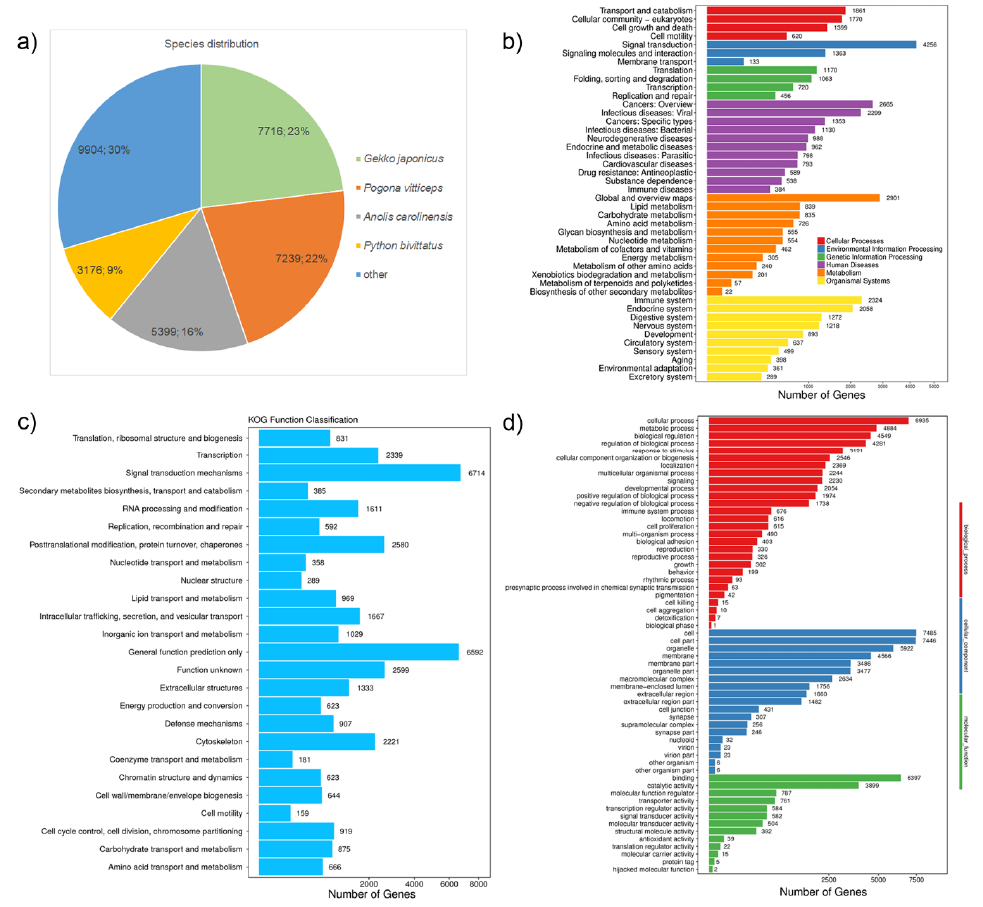
Figure 2. Annotation of the Asymblepharus ladacensis transcriptome. ( a ) Species distribution of the top BLASTx hit performed against NR database; ( b ) GO (Gene Onthology) assignments as predicted by Blast2GO; ( c ) functional distribution of KOG (EuKaryotic Orthologous Groups) annotation and ( d ) KEGG (Kyoto Encyclopedia of Genes and Genomes) classifications of assembled transcripts. In terms of the biological process ontology (GO database categories), the most com- mon categories were cellular processes (6935), metabolic processes (4884), and biological regulation (4549). The most frequent classifications for the cellular component ontology were cellular (7485), cell compartments (7446), and organelles (5922). Regarding the mo- lecular function, major categories involved binding (6397), catalytic activity (3899), and molecular function regulator (787) (Figure 2). The KOG functional classification revealed genes of signal transduction mechanisms (6714), general function (6592), unknown func- tion (2599), posttranslational modification (2580), and transcription (2339) as top five cat- egories (Figure 2).